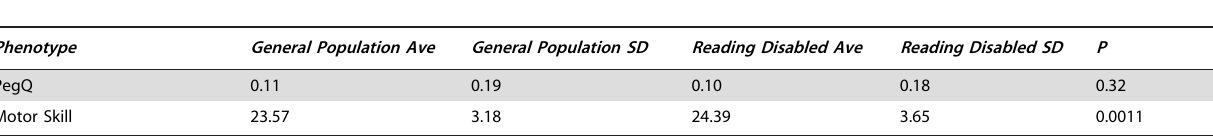
Table 2. Individuals with reading disability (cohort 3, n =169) are no more skilled with their left- or right- hand (PegQ)